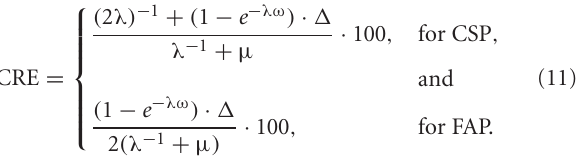
demonstrating a “inverse effectiveness” for CSP. The peripheral processing times for the auditory and visual stimuli are 1 / λ A = 1 / λ V equal to 20 (blue line); 40 (green); 60 (red); 80 (cyan); and 100 (magenta). Mean second stage processing time is μ = 100. Interaction parameter is (cid:2) = 20.[all values in